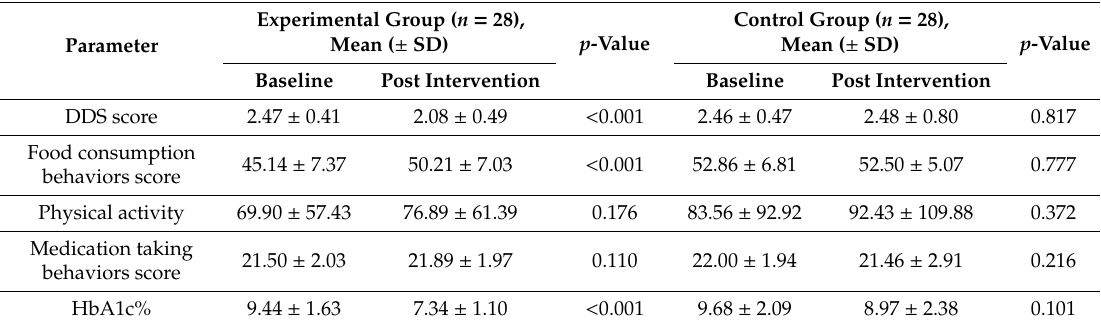
Table 2. Comparison of pretest and post-test within group means (paired t-test).